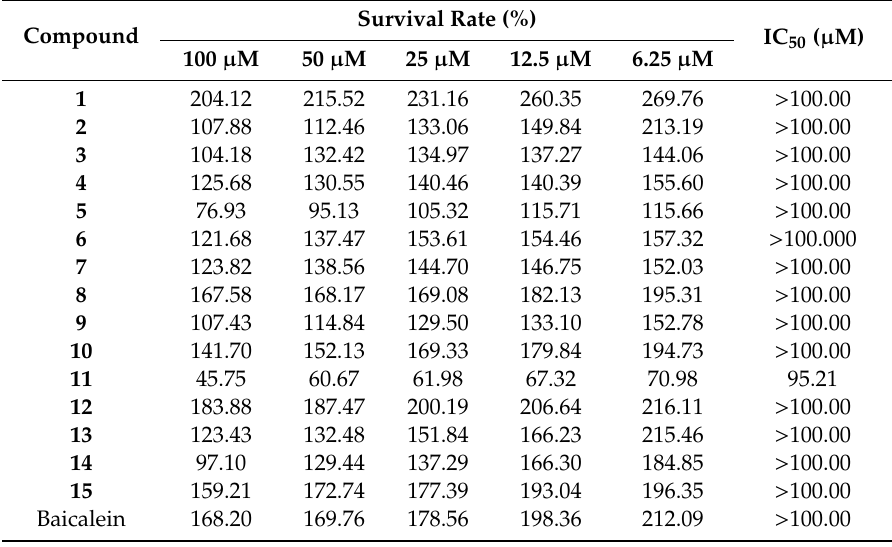
Table 3. The 50% inhibition concentration (IC 50 ) of the baicalein derivatives for H9C2 cells.